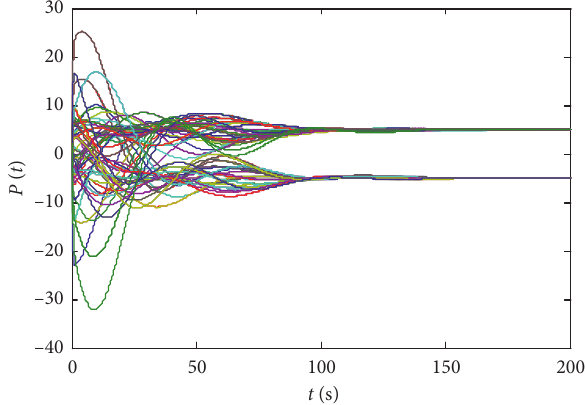
Figure 2: The response curves of the connection matrix P ( t ) .